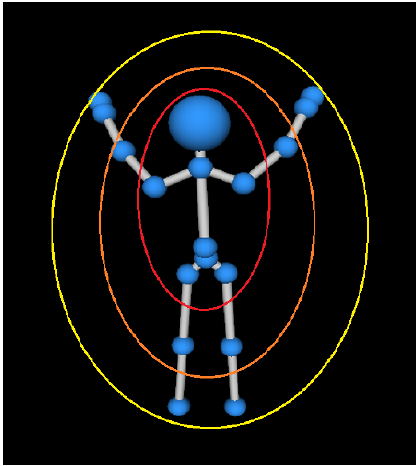
Figure 2: Map of limb factor areas used in the conse- quence analysis. Red indicate a higher limb factor, yellow a